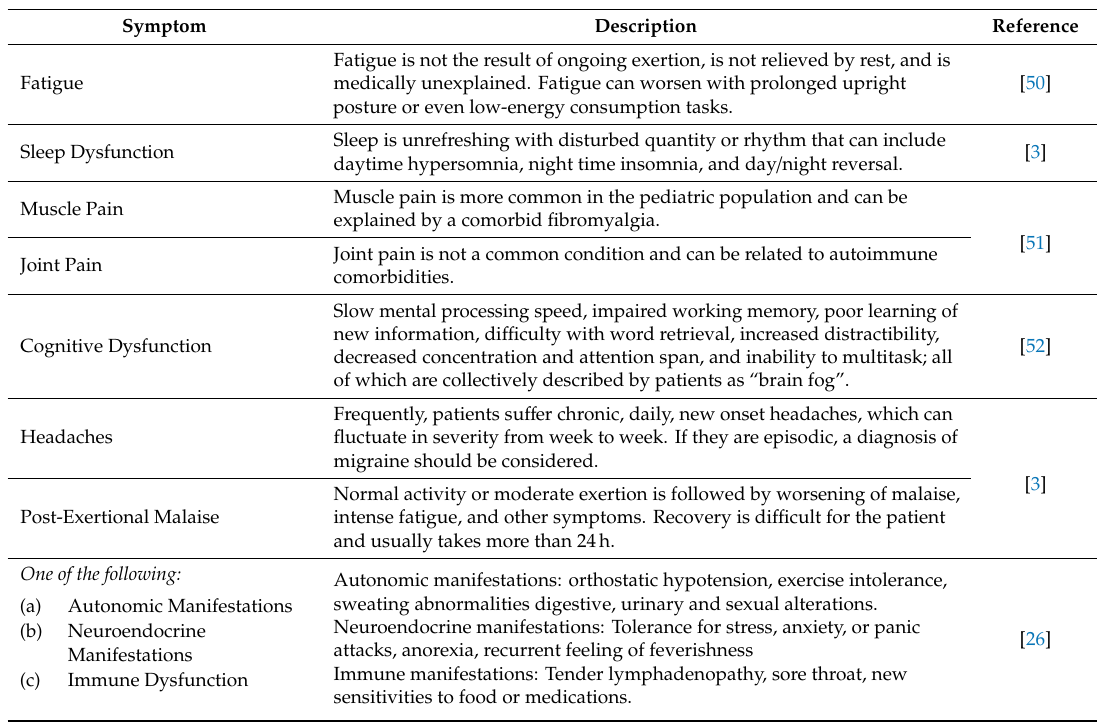
Table 2. Common symptom range and key features of myalgic encephalomyelitis / chronic fatigue syndrome patients (ME /